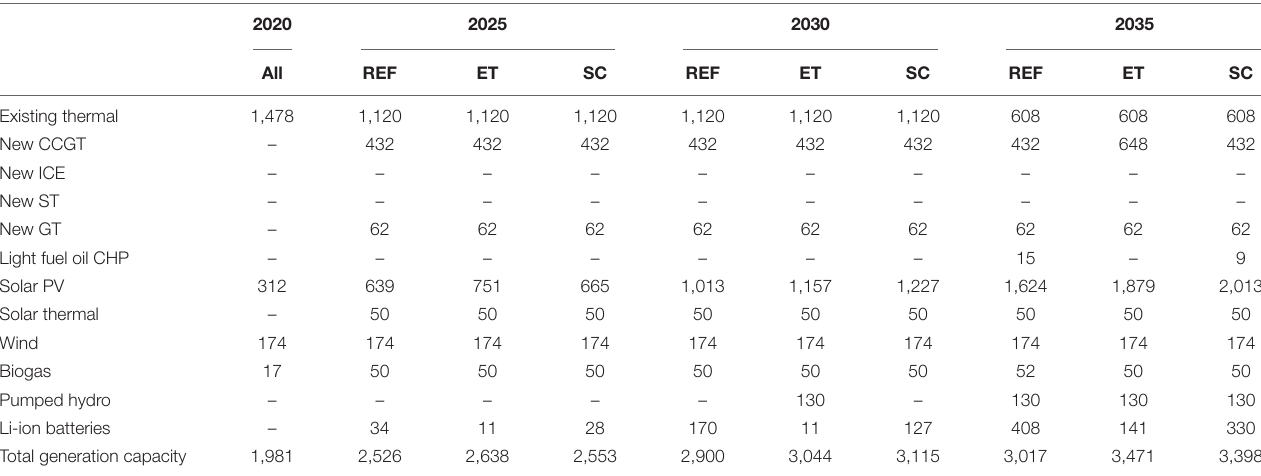
FIGURE 1 | Daily charging profile of private BEVs and PHEVs (adapted from Robinson et al., 2013). Due to insufficient information on charging behavior of electric vehicle owners in Cyprus, information from relevant literature is used as input to the model. Two peaks are observed in the assumed profile, one in the middle of the day, which corresponds to the peak PV generation period, and a larger peak in the evening. TABLE 3 | Capacity evolution (in MW) for each technology in each scenario